Question: In one sentence, what is this figure communicating?
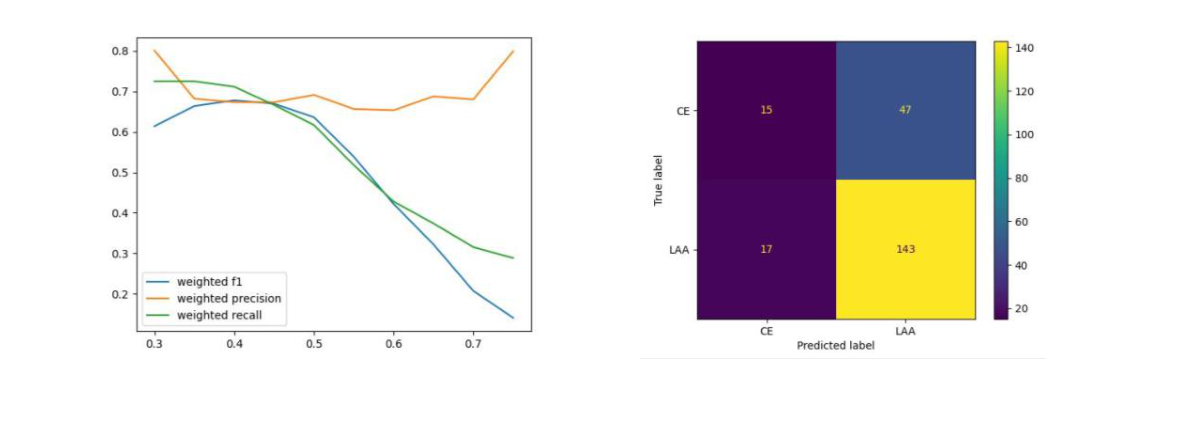
Answer: Evaluation metrics combining weighted F1 score, precision, and recall curves (A) and confusion matrix of